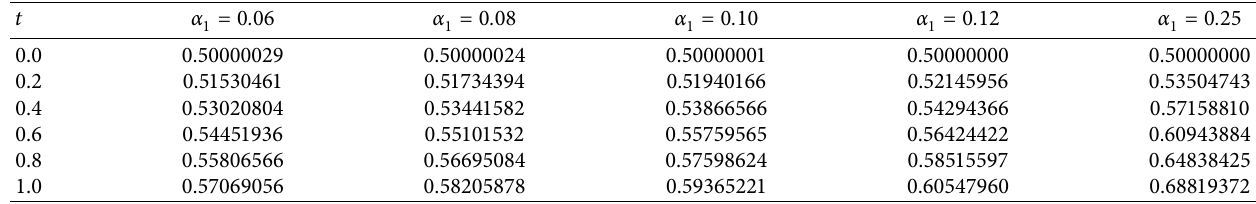
Table 3: Approximate solutions obtained by the LeNN-WOA-NM algorithm for population density of local prey S ( t ) under the influence of the intrinsic growth rate of local prey α . 1